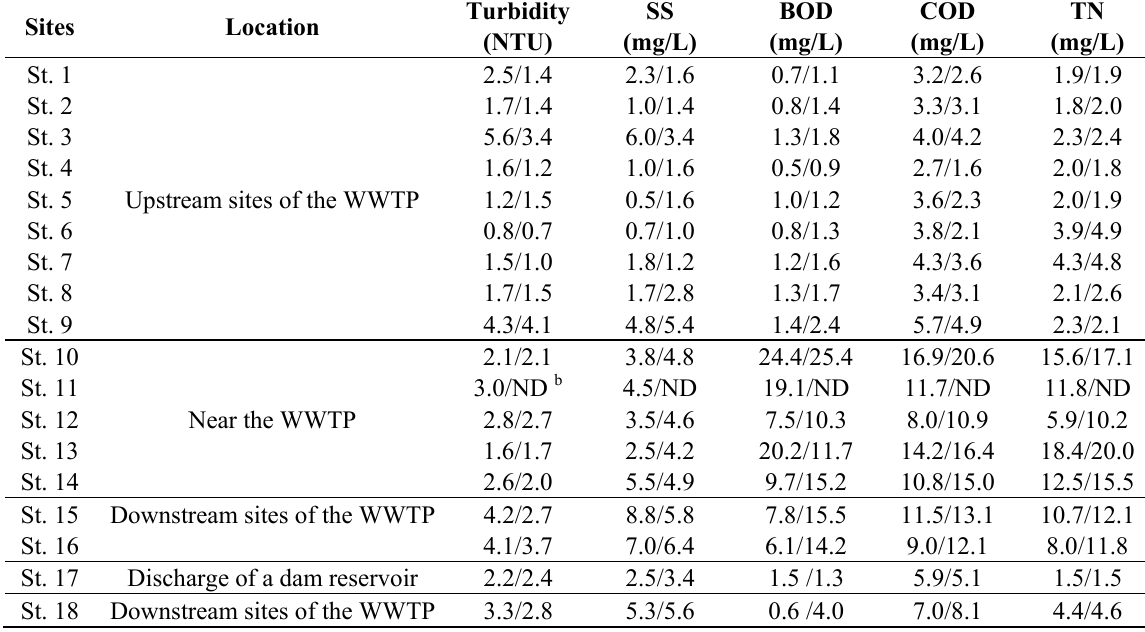
Table 1. Monitoring data of turbidity, SS, BOD, COD, and TN concentrations for the